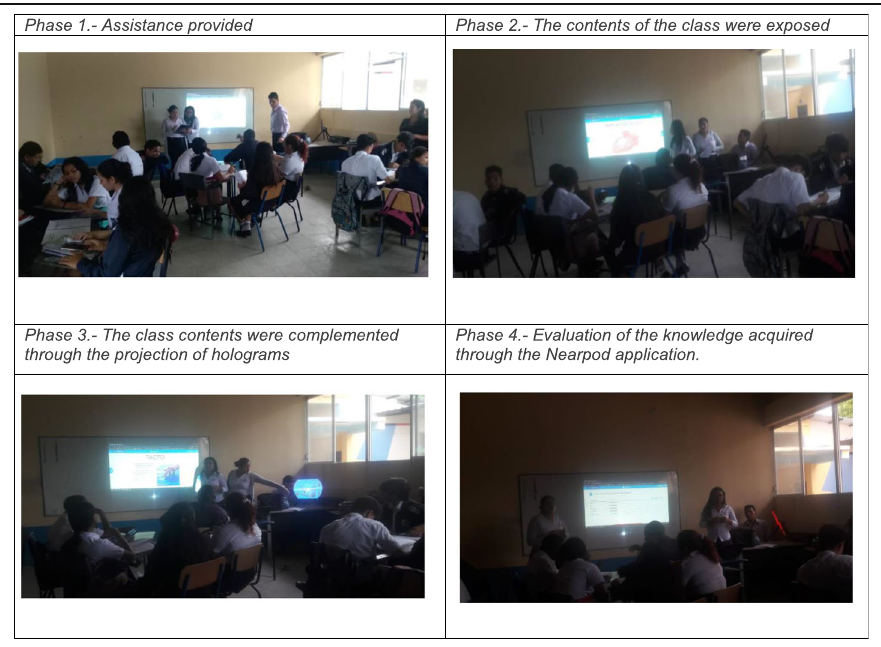
Table 7 Phases of experimental class of